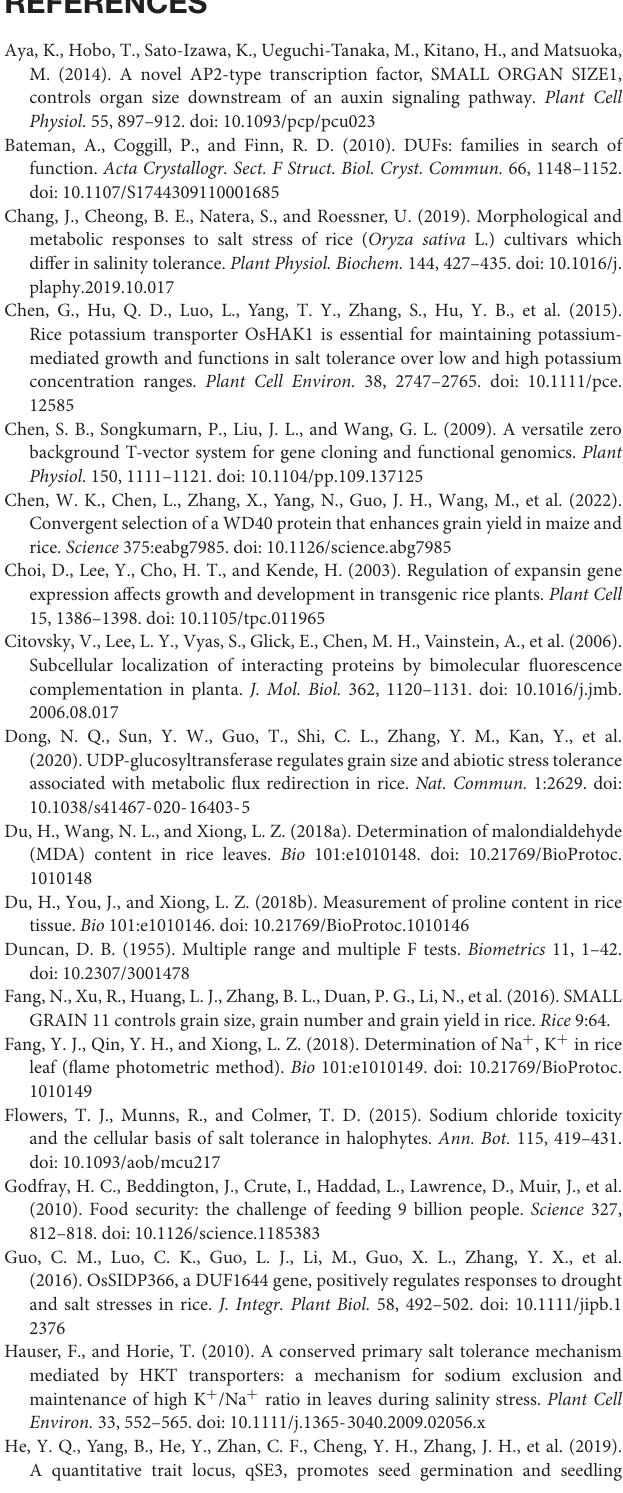
Supplementary Table 3 | Differentially Expressed Genes (DEGs) between WT, OsSIDP301 OE , and OsSIDP301 RNAi from RNA-seq analysis, and using young panicle as the